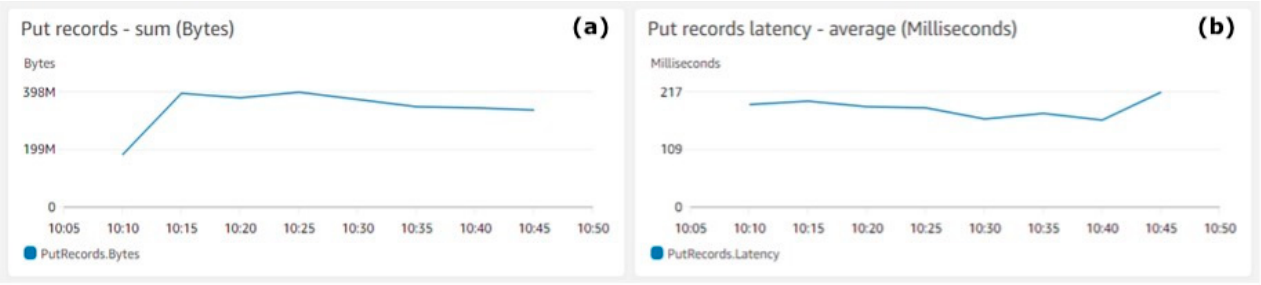
Figure 4. Kinesis Data Stream put records. ( a ) Put records—sum (bytes), ( b ) Put records latency—average